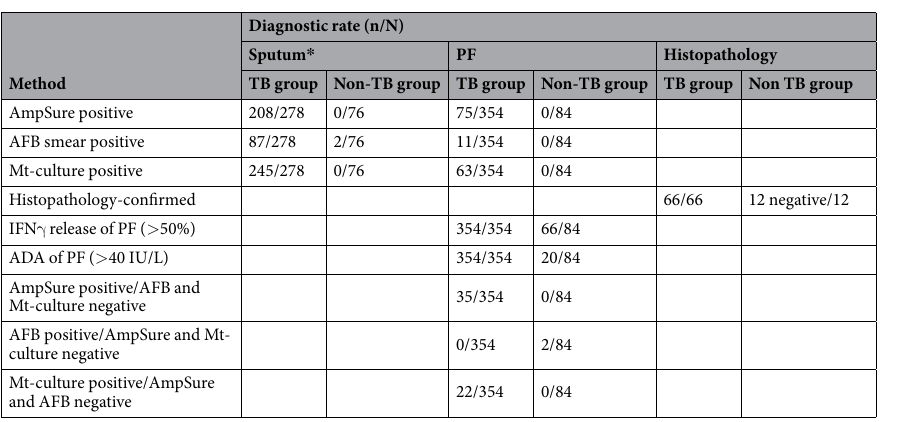
Table 2. Summary of results of the diagnostic tests. * Sputum from 278/354 TB cases and from 76/84 non-TB cases was examined. AFB, acid-fast bacilli; PF, pleural fluid; Mt, Mycobacterium tuberculosis ; IFN γ , interferon gamma; ADA, adenine deaminase.